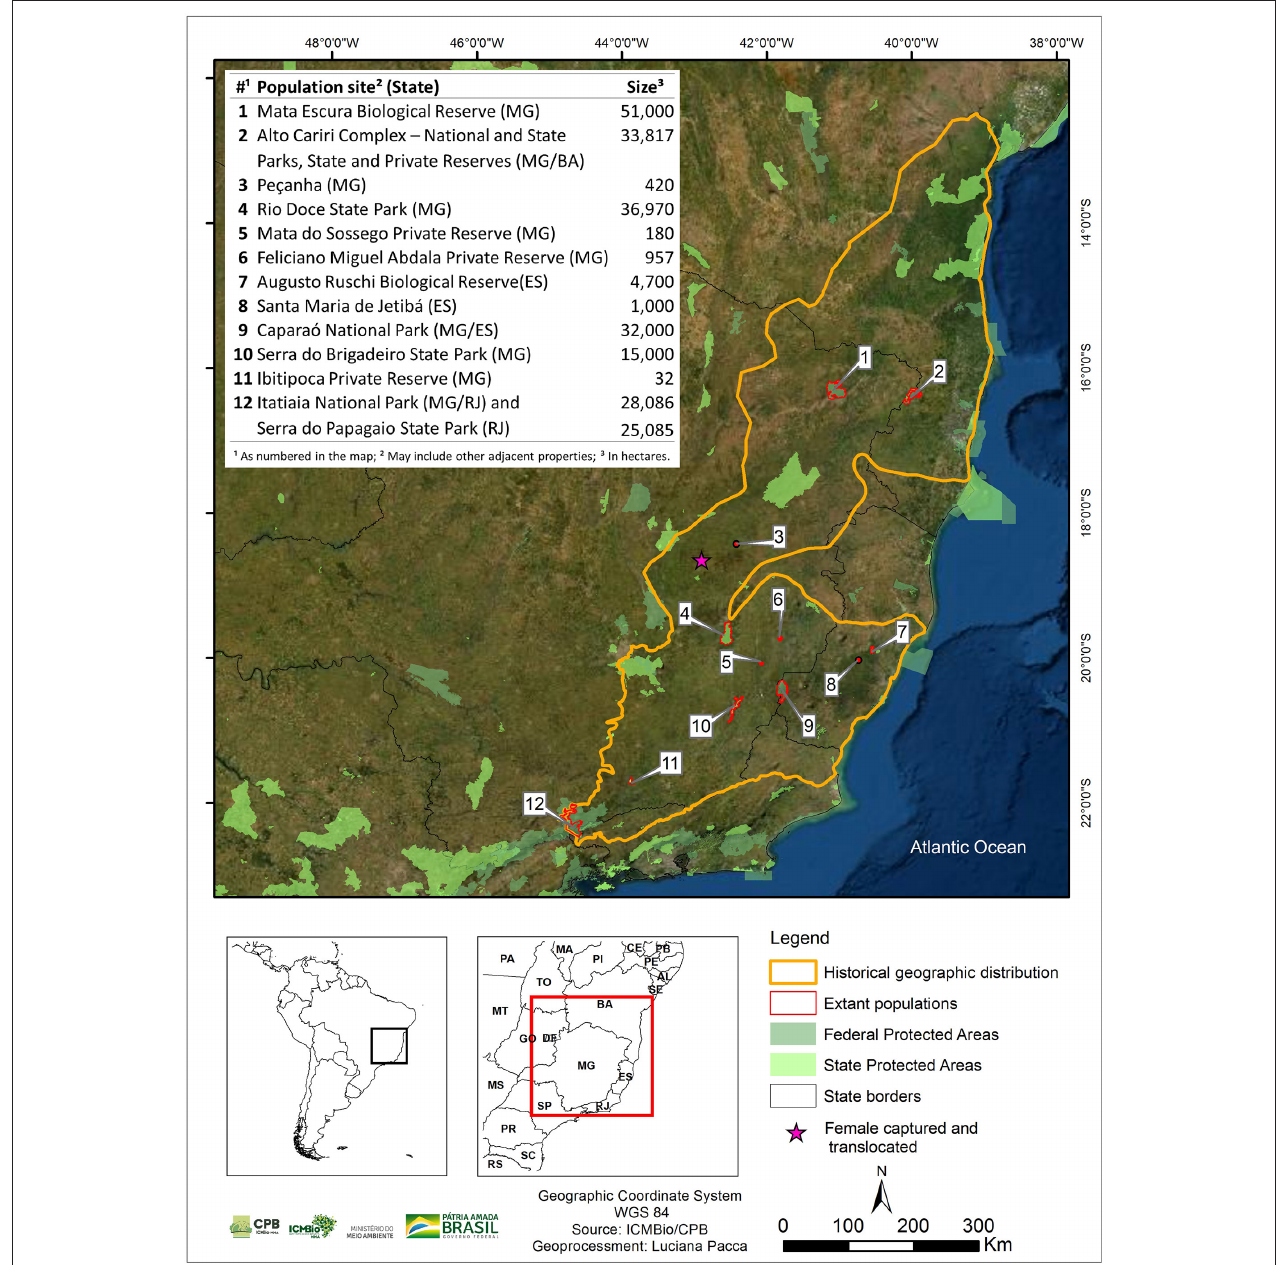
FIGURE 1 | Historical distribution and extant populations of the northern muriqui, Brachyteles hypoxanthus . The historical distribution was adapted from Aguirre (1971), Ingberman et al. (2016), and Melo et al. (2018). For context of the translocated female indicated by the star, see Table 1 ; for other cases of translocated northern muriqui females, see Tabacow et al.